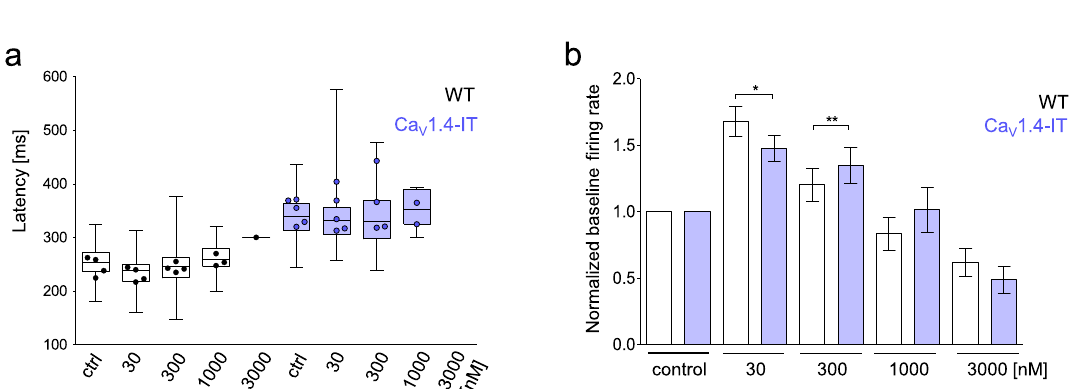
Figure 8. Effect of the L-type calcium channel blocker nilvadipine on retinal ganglion cell activity. ( a ) ON and OFF ganglion cell light response latencies measured under scotopic conditions; in the box plot data are mean ± SD given in [ms], n describes the number of responding ganglion cells: wild type (WT): control ringer solution: 255.1 ± 36.7, n = 156; nilvadipine: 30 nM: 239.1 ± 33.6, n = 158; 300 nM: 256.6 ± 34.9, n = 151; 1 µM: 271.6 ± 35.1, n = 103; 3 µM: 300.1 ± 0, n = 1. Ca V 1.4-IT: control ringer solution: 339 ± 43.6, n = 69; nilvadipine: 30 nM: 339.3 ± 64.15, n = 61, 300 nM: 336 ± 61.9, n = 42, 1 µM: 355.0 ± 30.9, n = 11, 3 µM: none responding. Box and whiskers datasets represent mean, 25th to 75th percentiles and minimum to maximum values for all the ganglion cells recorded. The circles, however, represent the number of animals with responding ganglion cells: WT, N = 4; Ca V 1.4-IT, N = 4. No statistical difference was observed. ( b ) The baseline firing activity was recorded 5 s after the full-field flash under grey background stimulation. For each concentration, the baseline firing rate was normalized to the control condition: data are presented as mean ± SEM in [Hz], WT: nilvadipine: 30 nM: 1.67 ± 0.11; 300 nM: 1.20 ± 0.12; 1 µM: 0.83 ± 0.12; 3 µM: 0.61 ± 0.11, n = 158; IT: nilvadipine: 30 nM: 1.48 ± 0.10; 300 nM: 1.35 ± 0.14; 1 µM: 1.01 ± 0.17; 3 µM: 0.49 ± 0.10, n = 69. WT, N = 4. Ca V 1.4-IT, N = 4. Two-tailed Mann Whitney test, *, p = 0.0195; **, p =